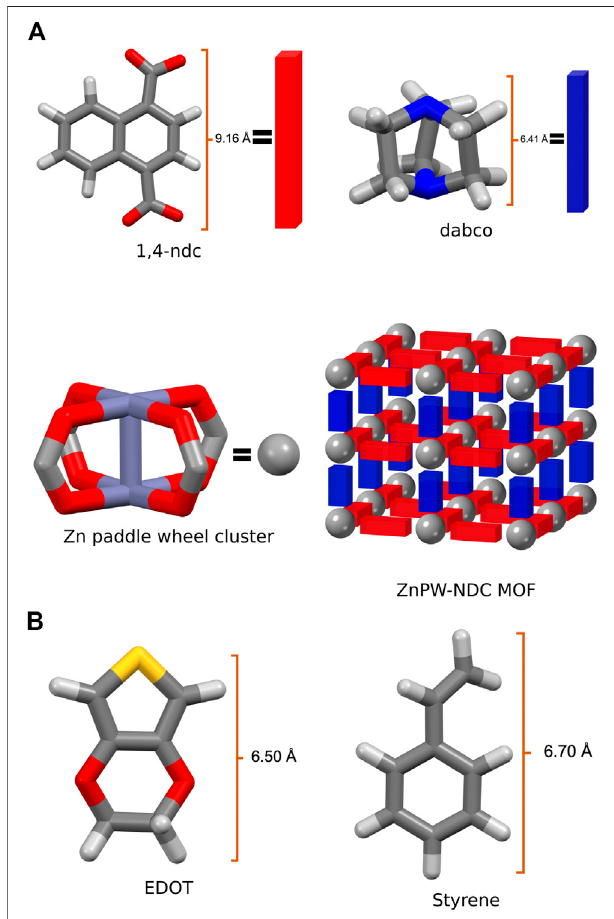
FIGURE 1 | (A) the secondary building units of Zn 2 (1,4-ndc) 2 (dabco), represented as a net, where the organic linkers constitute the edges and the metal cluster the nodes, (B) Illustration of monomers EDOT and Styrene.